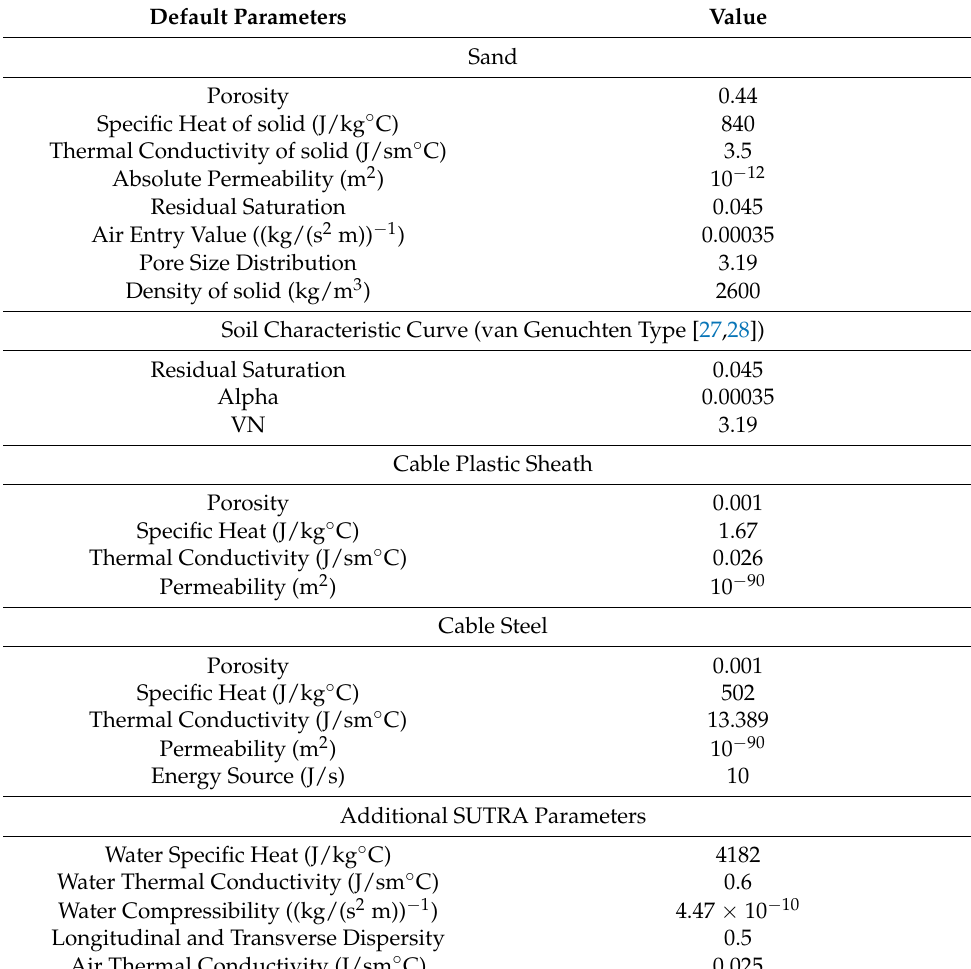
Table 1. Base model